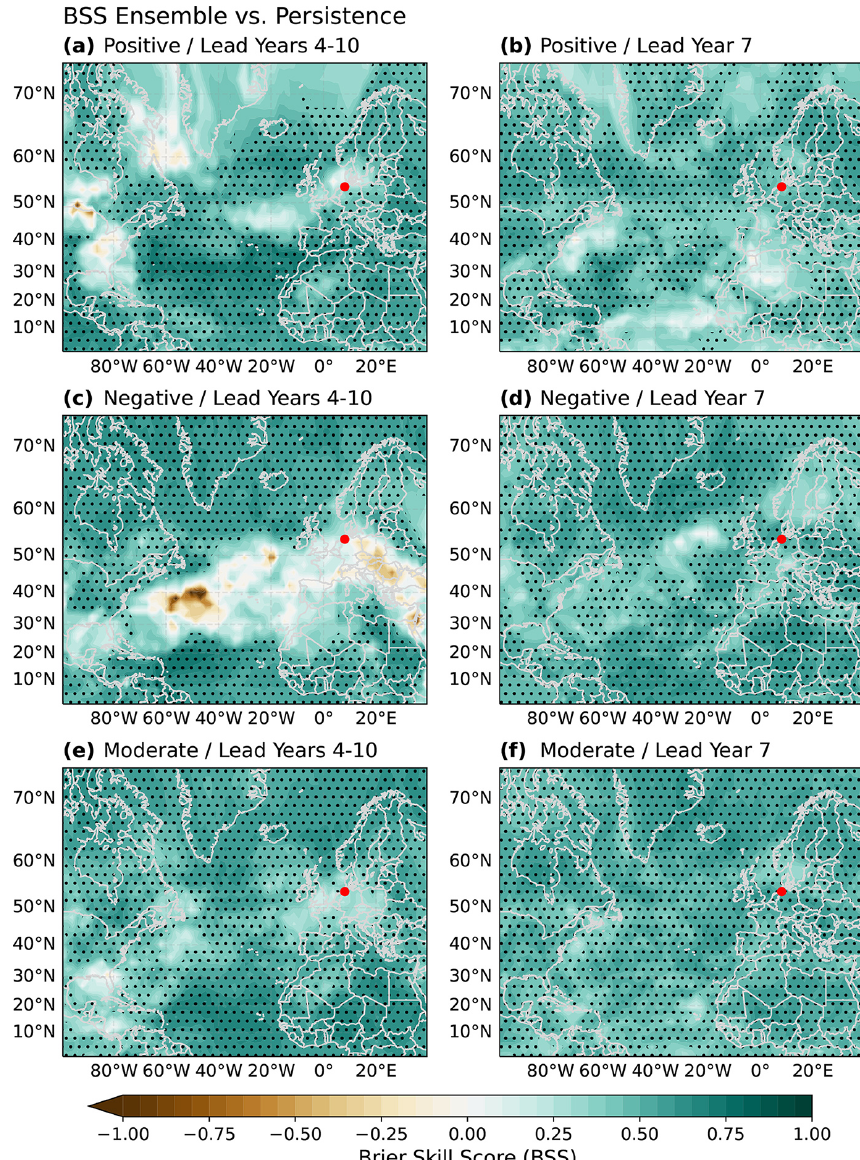
Figure 6. Prediction skill of probabilistic forecasts of positive (a, b) , negative (c, d) , and moderate (e, f) winter mean (DJF) MSLP anomalies, expressed as the Brier skill score (BSS) of the 64-member ensemble evaluated against a persistence prediction as a baseline for lead years 4– 10 (a, c, e) and lead year 7 (b, d, f) . Thresholds for event detection are set to − 1 and 1. The German Bight is marked by a red dot. Stippling marks areas with a BSS significantly different from 0 ( p ≤ 0 .